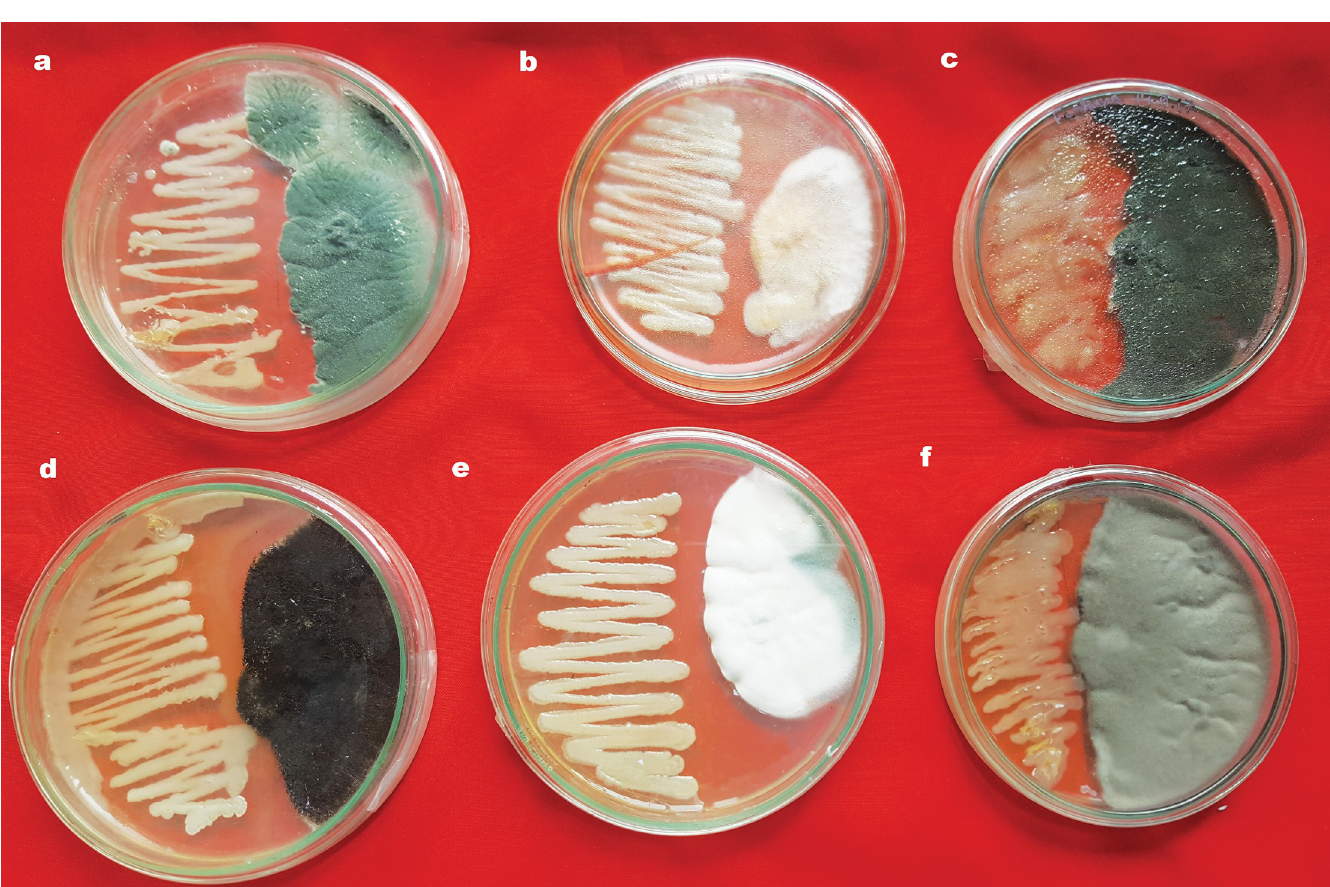
Fig 2. Antagonistic properties of B . contaminans NZ against six other phytopathogenic fungi. (a) Nigrospora sphaerica (b) Xylaria spp.(c) Aspergillus fumigatus (d) Aspergillus niger (e) Penicillium oxalicum , and(f) Rhizoctonia solani .